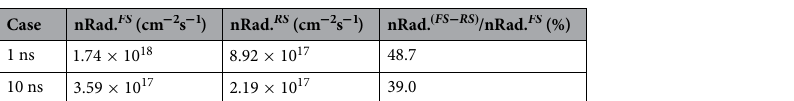
Table 2. Non-radiative recombination rates at 0.6